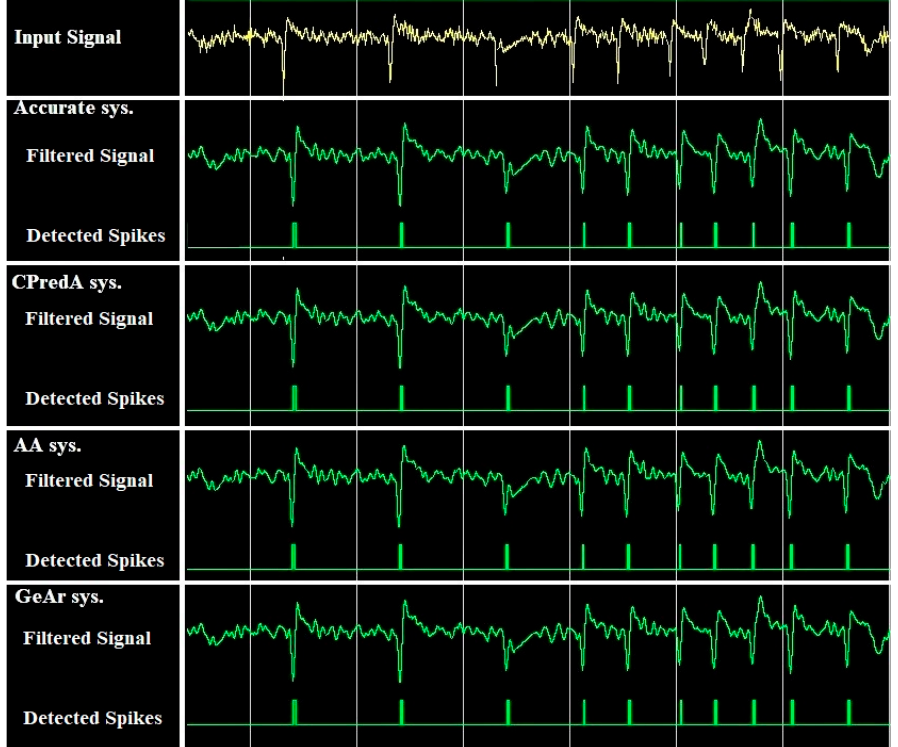
Figure 13. Sample test of signal filtering and spike detection for the processing systems in Mode 1.